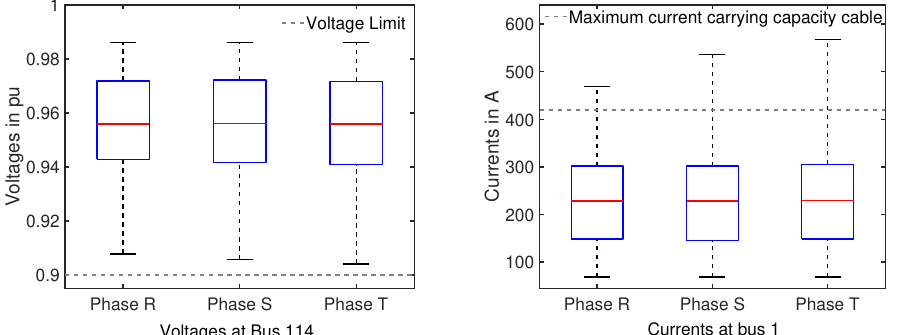
Figure 13. Phase voltages at bus 114 and phase currents at bus 1 for GHG emission optimized vehicle charging.